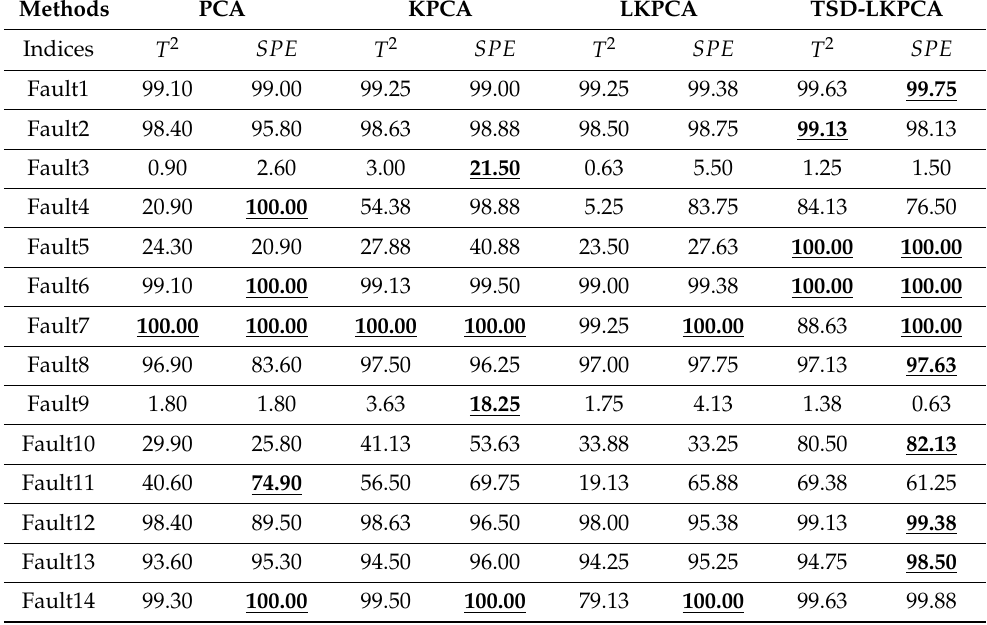
Table 5. Monitoring results on the TE process